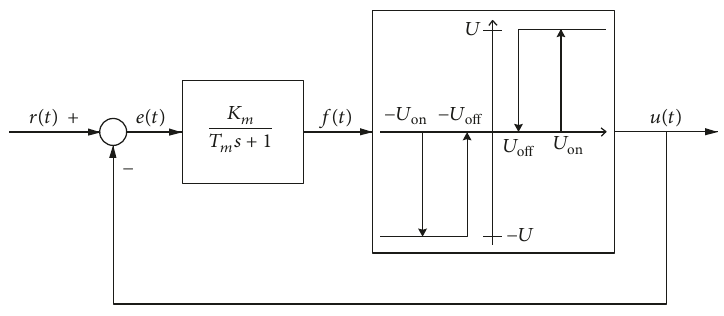
Figure 5: PWPF modulator circuit.